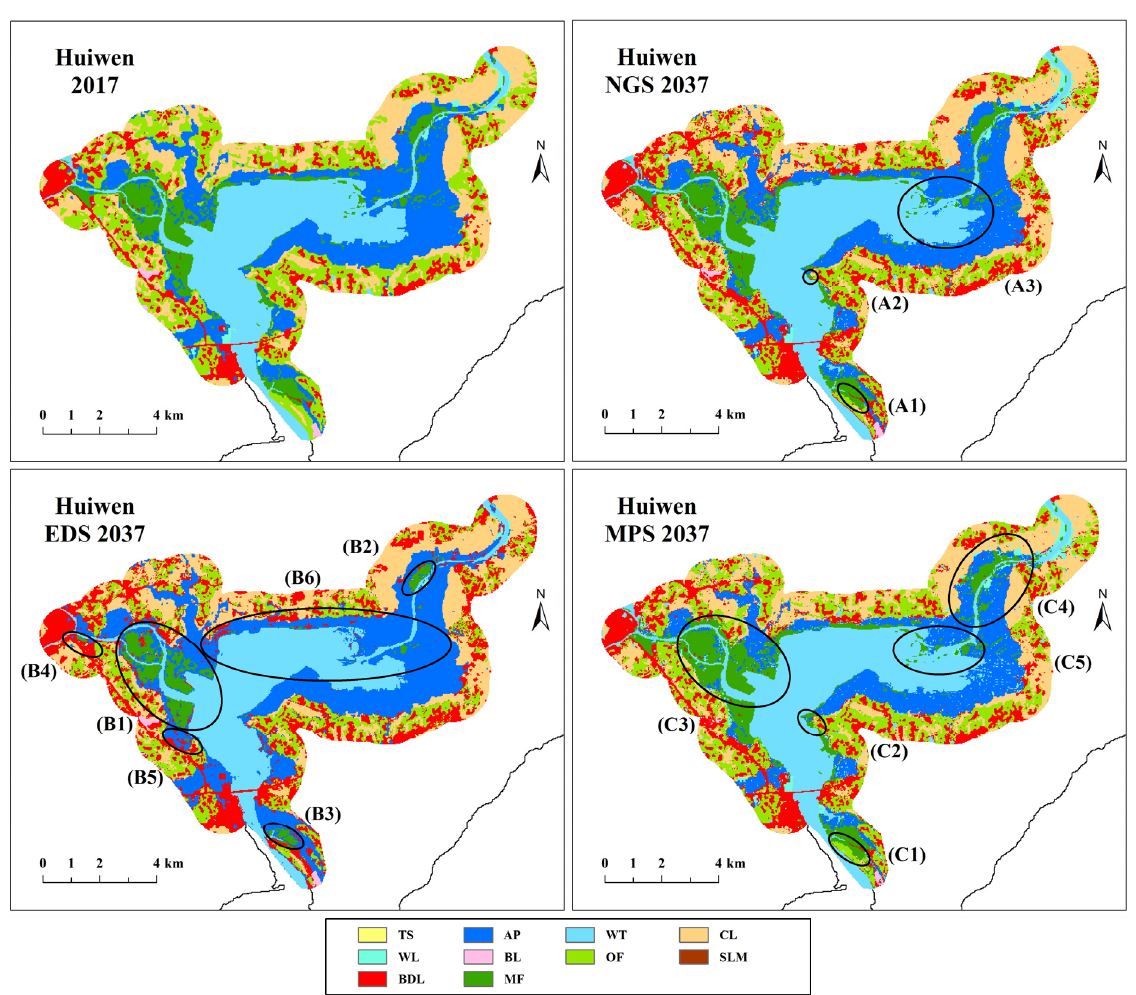
Figure 5. Comparison between the observation maps for 2017 and the simulation maps for 2037 in Huiwen under different scenarios.